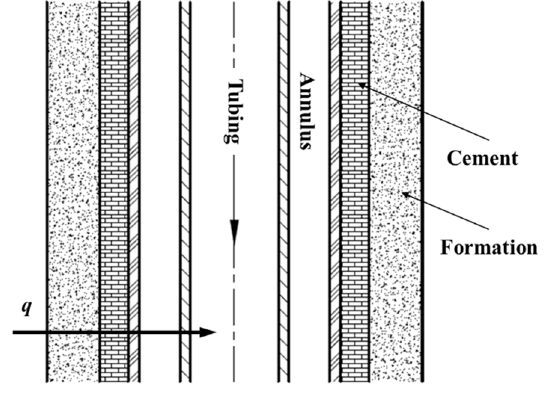
Figure 2. A finite element in wellbore.